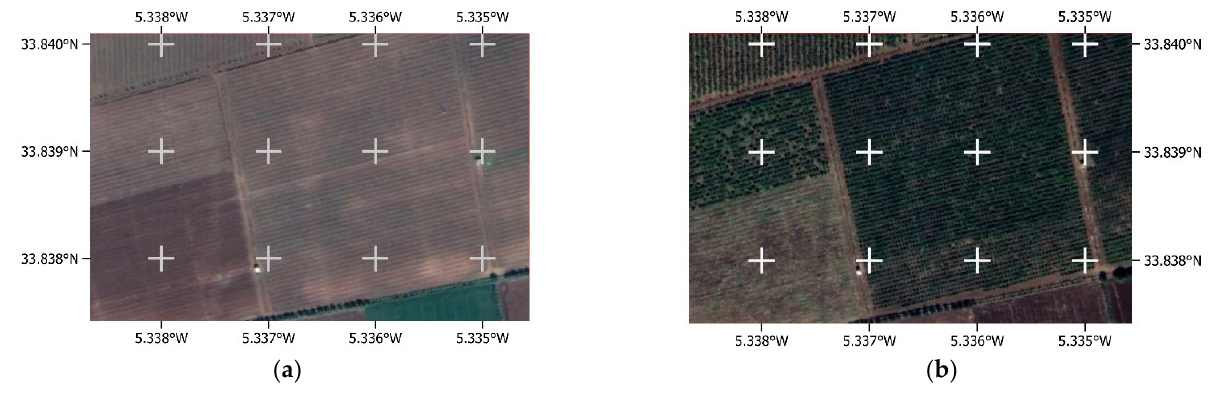
Figure 5. Bi-temporal photointerpretation of deciduous orchards. ( a ) Google Earth Image from Feb- ruary and ( b ) Google Earth Image from October, showing the visible difference in tree crown size and greening.